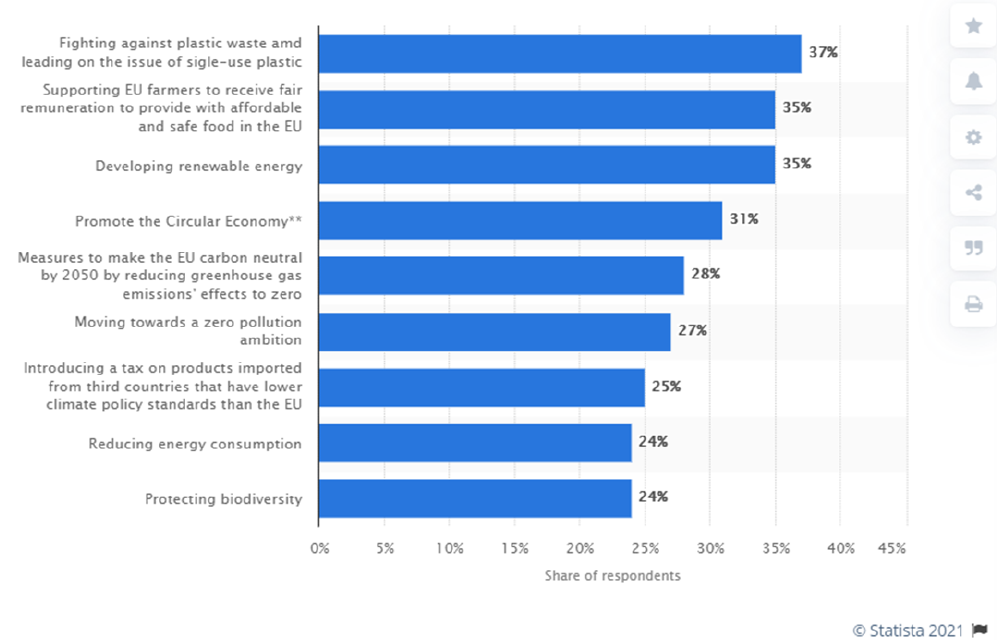
Figure A7. Romania: public opinion on the objectives in a European Green Deal 2019. Source: https://www.statista.com/statistics/1110123/european-green-deal-objectives-romania/ (accessed on 8 June 2021).